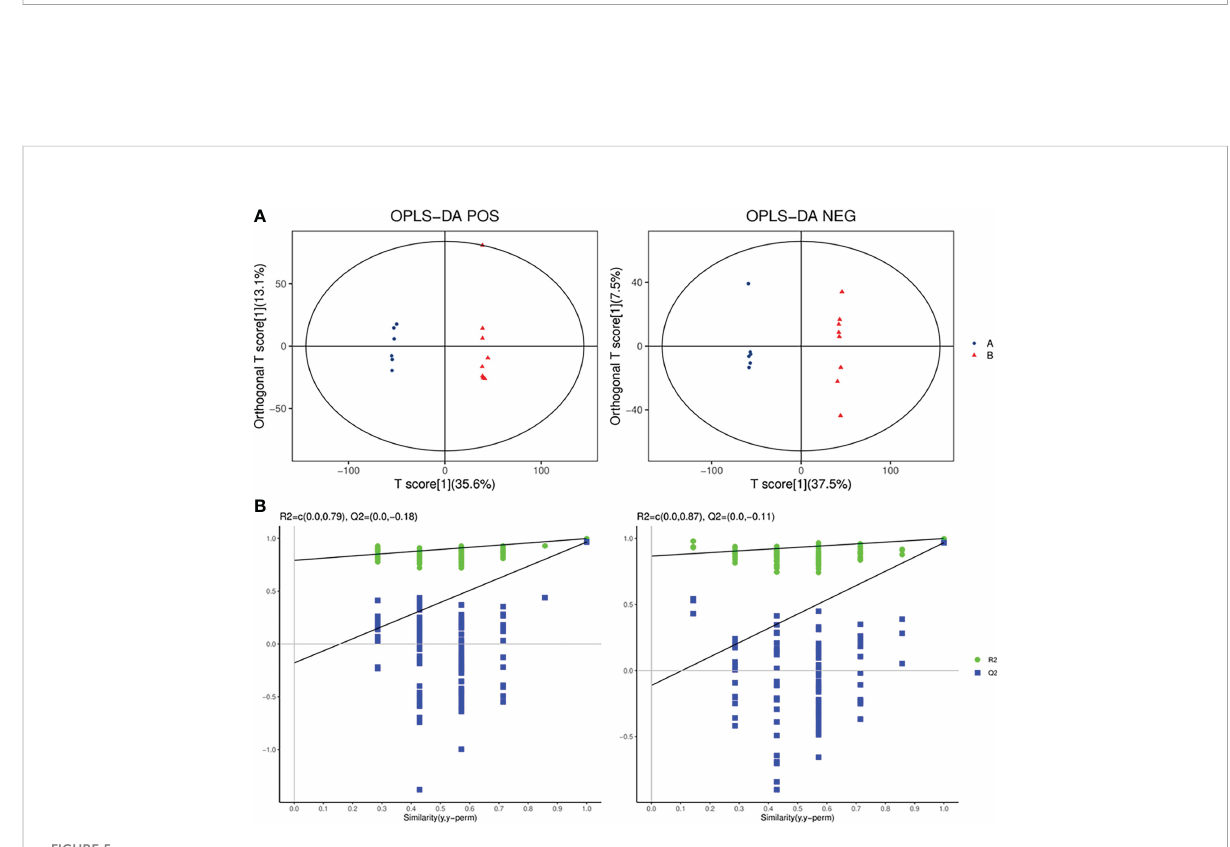
FIGURE 5 The plot of OPLS-DA score for SADI-S group and sham operation group in the positive ion mode and in the negative ion mode (A) ; permutations plot in the positive ion mode and in the negative ion mode (B) . A=SADI-S group, B=sham operation group.